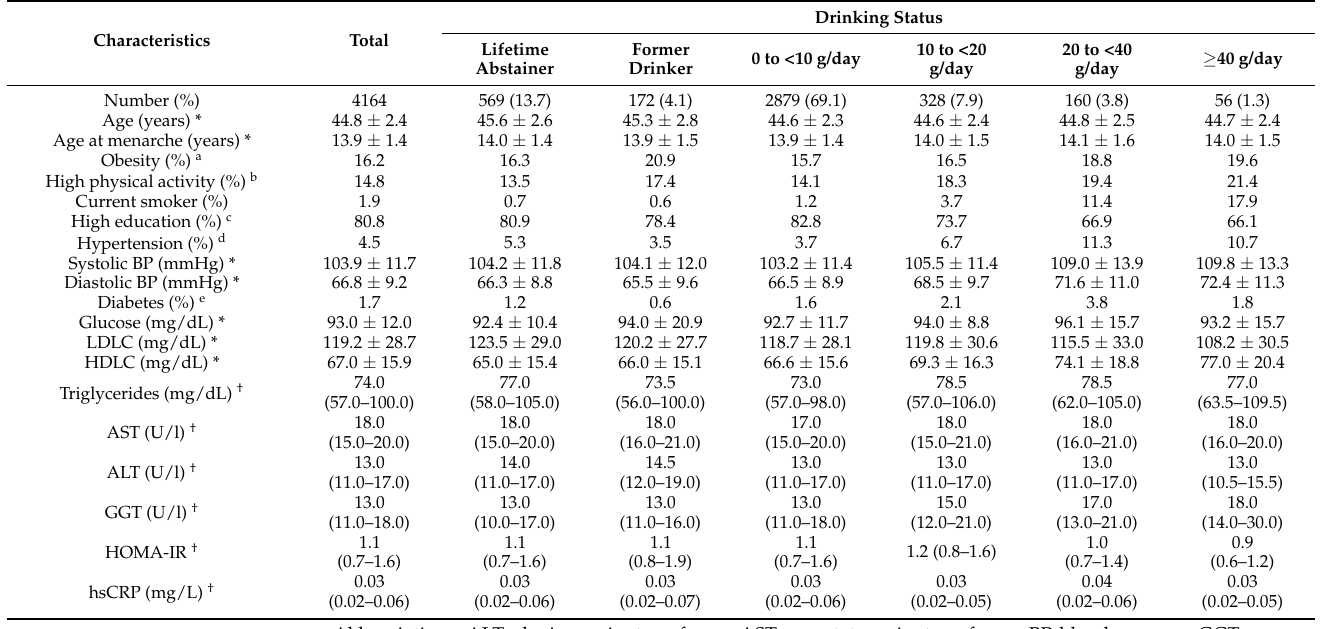
Table 1. Characteristics of premenopausal women in the cross-sectional study by drinking category ( n = 4164).